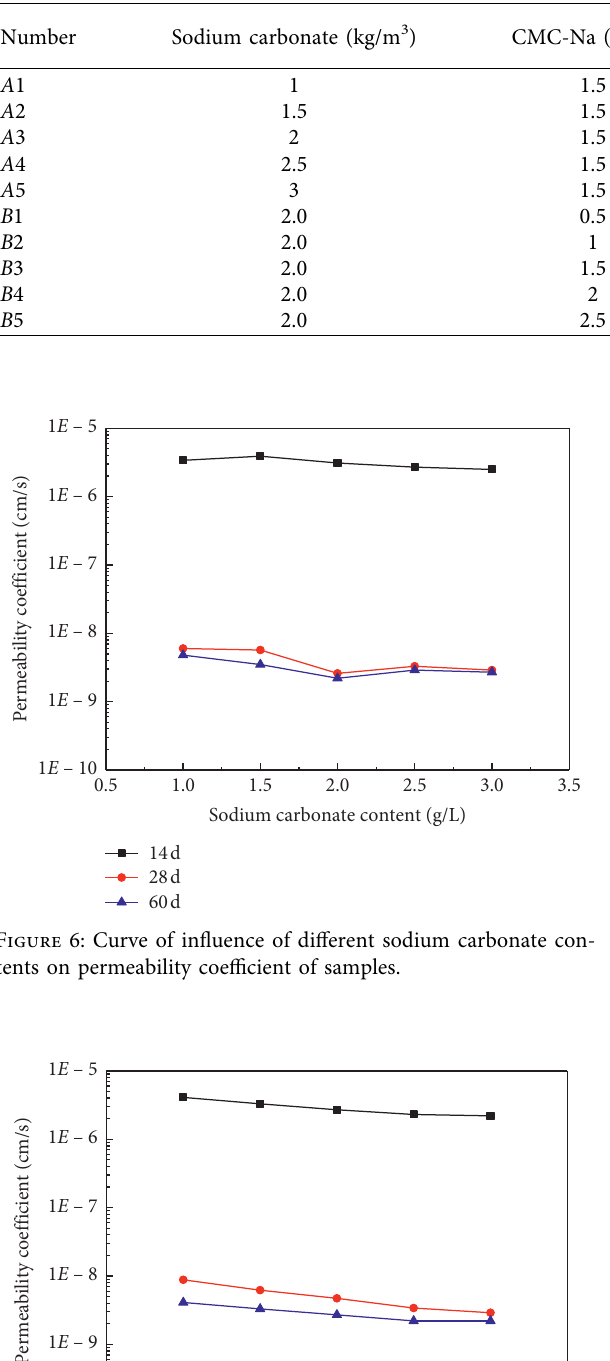
Table 6: Effects of sodium carbonate and CMC-Na content on permeability coefficient of test samples.